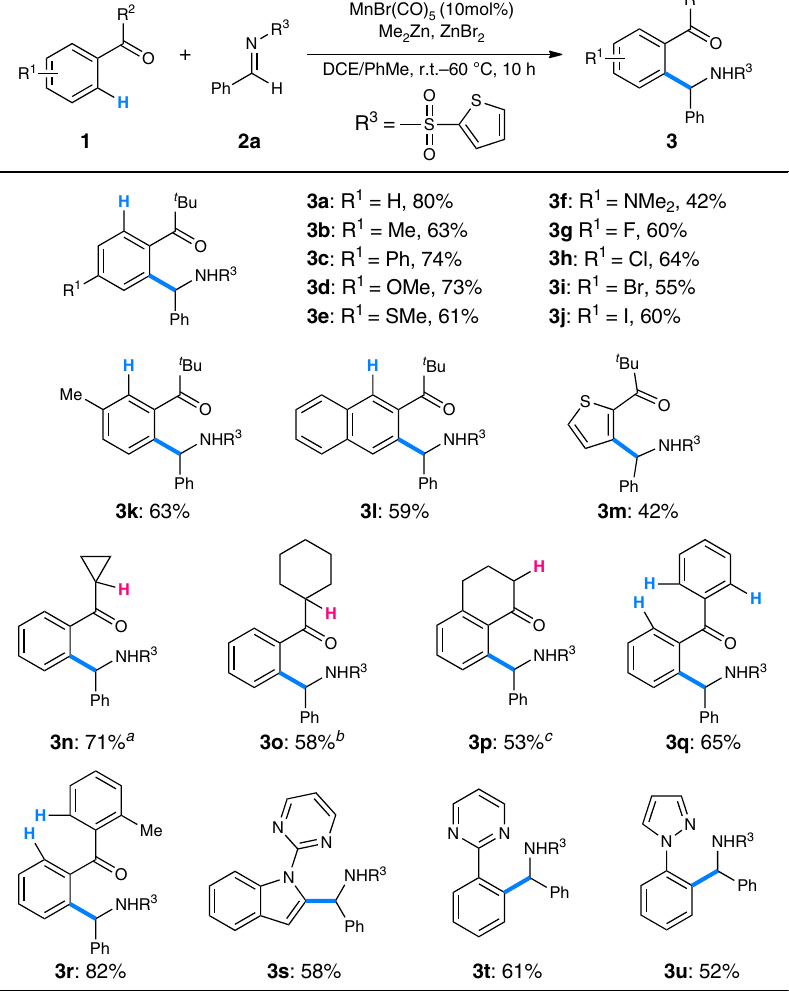
Fig. 3 Scope of ketones for the mono -C – H addition reaction. Reaction conditions: 1 (1.5 mmol), 2a (0.5 mmol), MnBr(CO) 5 (0.05 mmol), Me 2 Zn (0.75 mmol, 1.2 M in toluene), ZnBr 2 (0.5 mmol), DCE (0.4 M), 60 °C, 10 h. a 1n (2.0 mmol), DCM (0.1 M), r.t., 16 h. b 1o (2.0 mmol), DCM (0.1 M), r.t., 1 h. c 1p (2.0 mmol), DCM (0.1 M), 40 °C, 1 h. DCE 1,2-dichloroethane, DCM dichloromethane